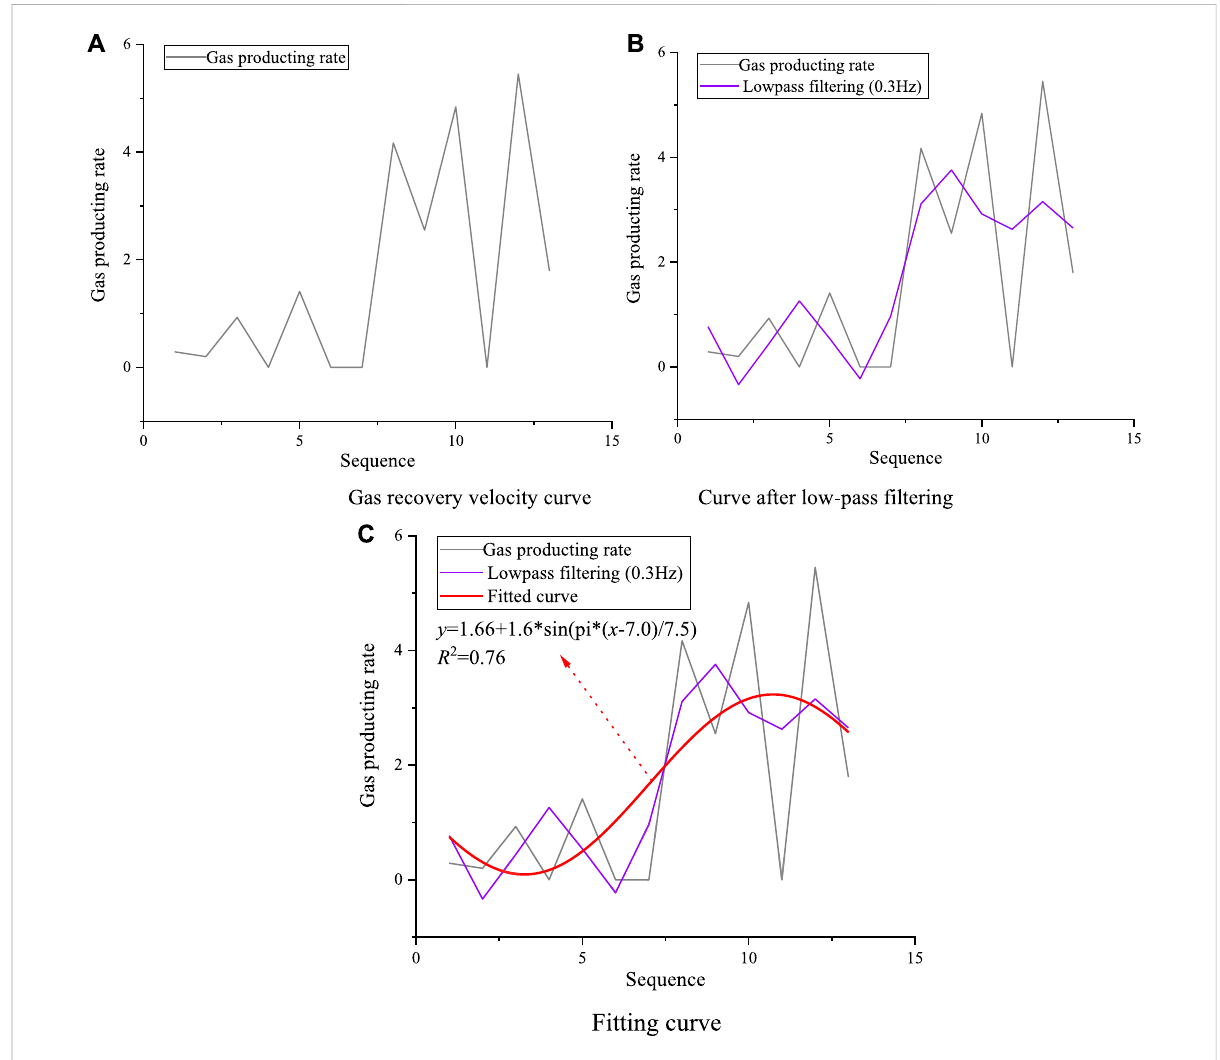
FIGURE 7 Processing of gas production velocity curve. (A) Gas recovery velocity curve (B) Curve after low-pass fi ltering. (C) Fitting